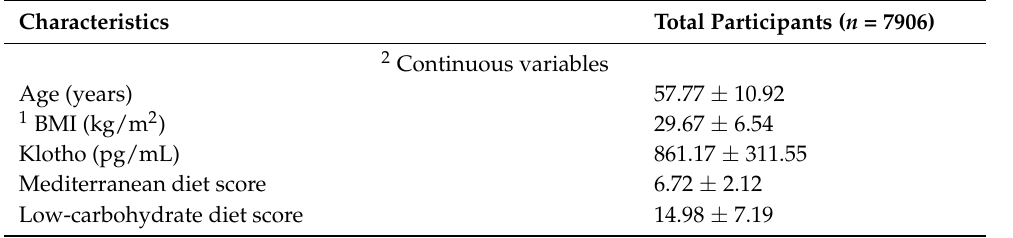
Table 1. Characteristics of